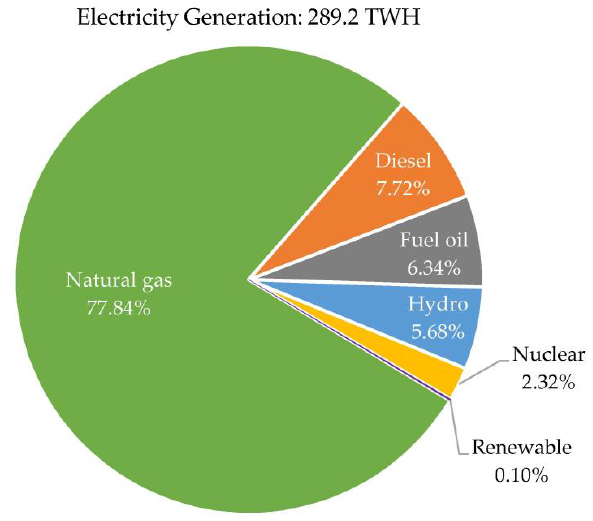
Figure 3. Fuel shares of Iran electricity generation, 2016–2017. Source: Based on [41].